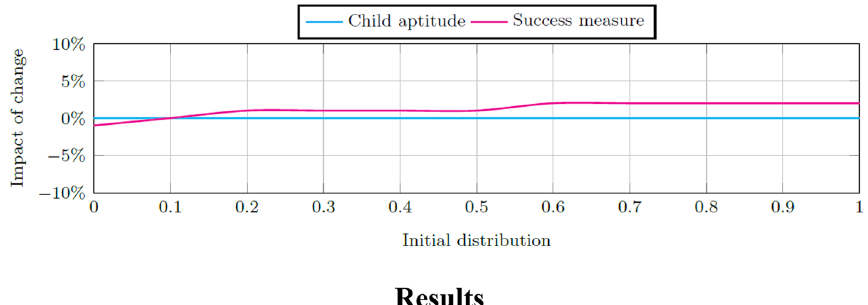
Fig. 10 Impact on the final child aptitude and success measure per change in the initial distribution of enrolled and not-enrolled children